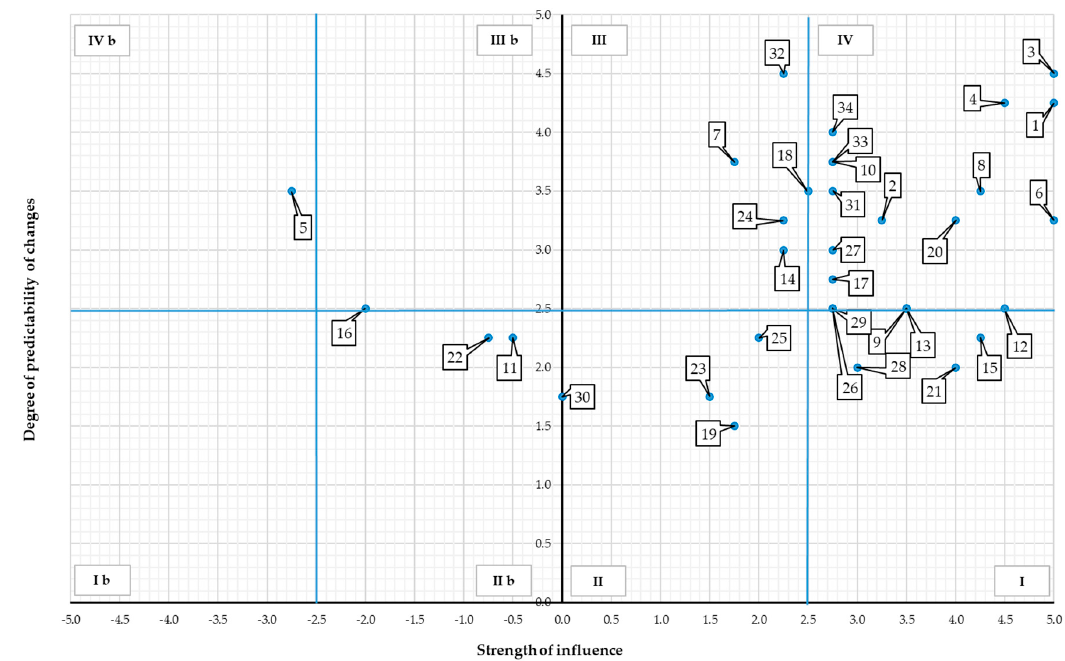
Energies 2021 , 14 , 2242 16 of 32